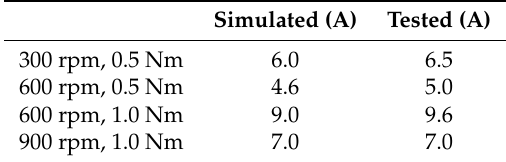
Table 2. Comparison of simulated and experimental phase current peak